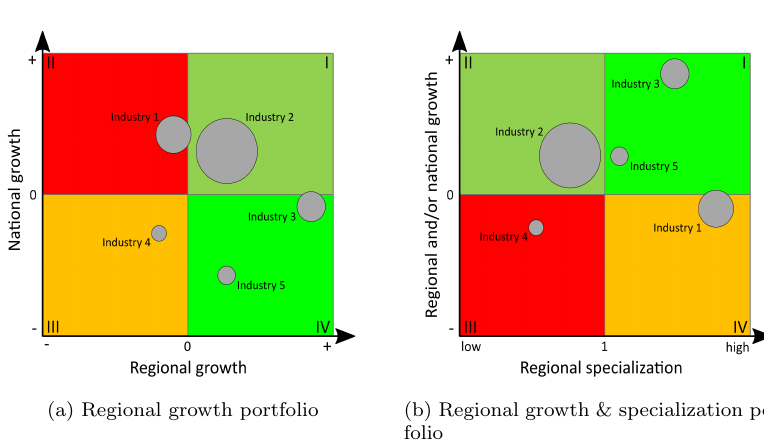
Figure 5: Regional economic portfolio